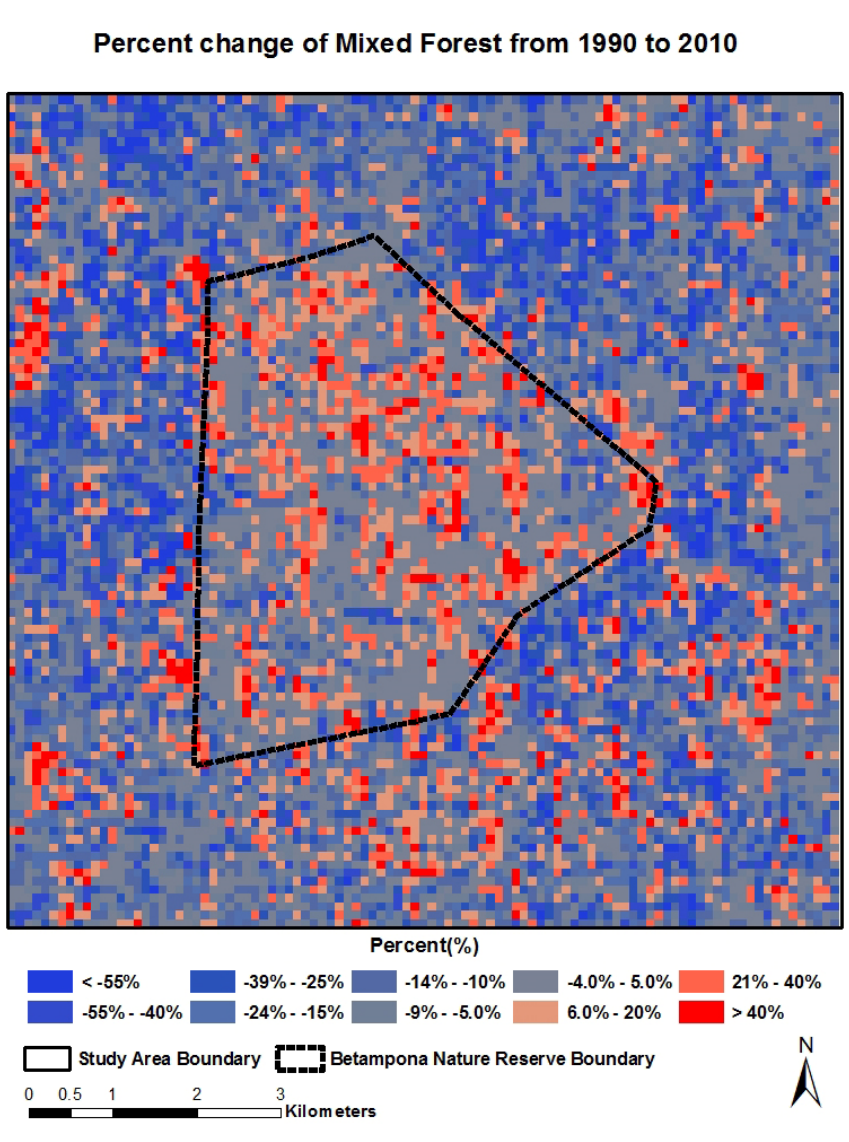
Figure 9. Percentage change of mixed forest in each grid cell from 1990 to